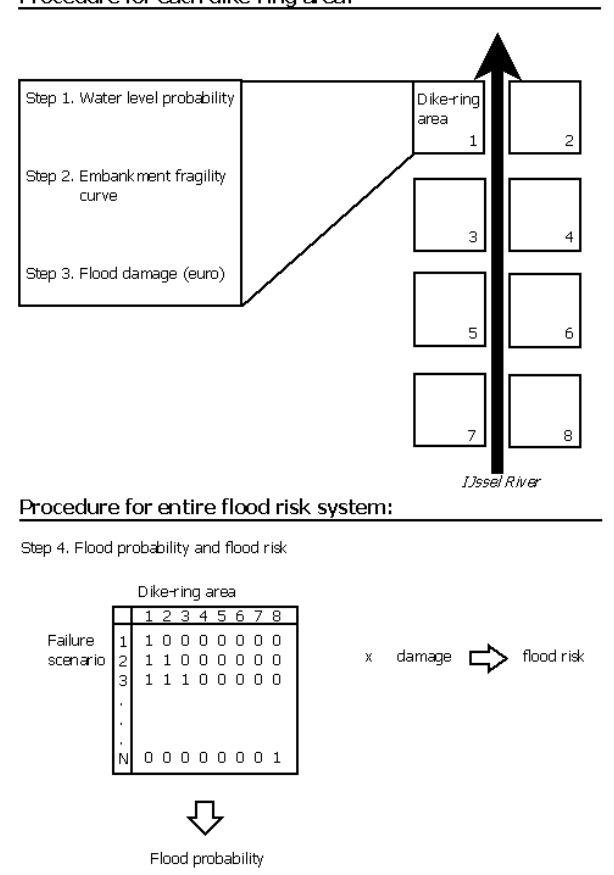
Figure 2. Steps in the flood risk analysis.